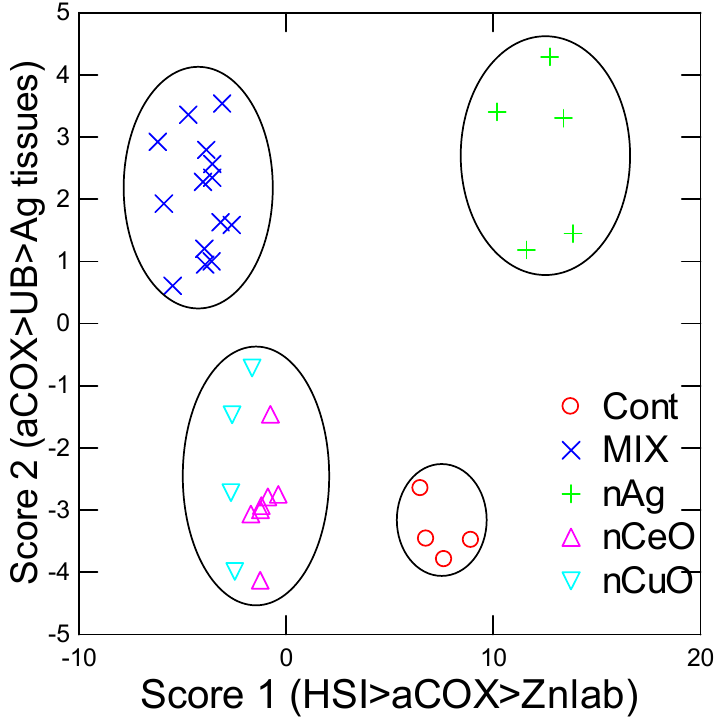
Figure 5. Discriminant function analysis of fish responses to nanoparticles. Discriminant function analysis was performed and revealed a mean classification efficiency of 71% and a total explained variance of 95%. The most important biomarkers are included in the parenthesis of each ax.